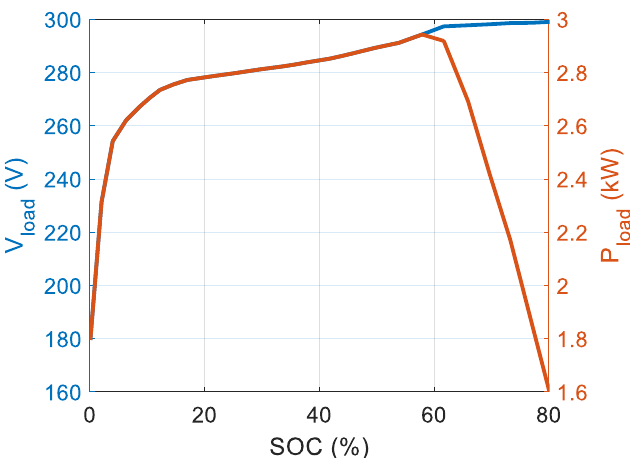
Figure 11. Modelled voltage and power profile of the load for the design of the prototype.